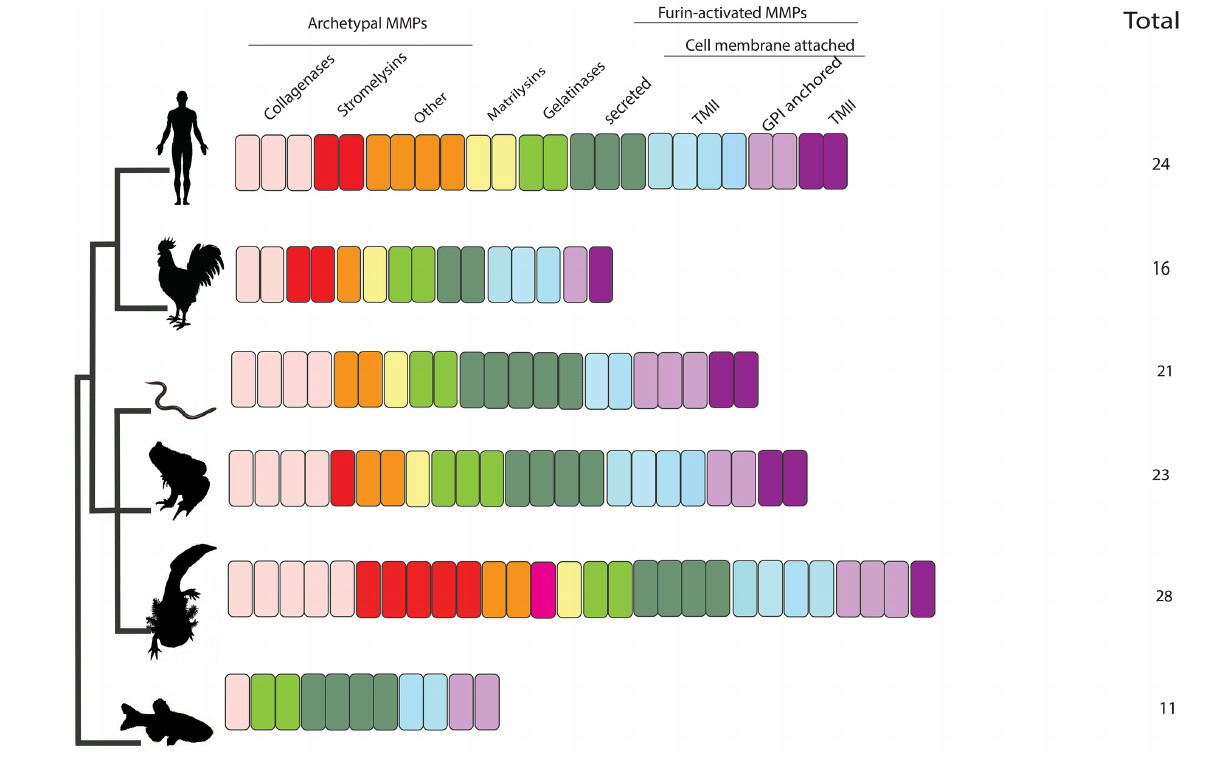
FIGURE 3 | Summary of number and classification of MMPs in axolotl and other tetrapods included in this study. Salamanders are predicted to encode the highest number of MMPs (28 gene members). Salamanders encode five collagenases:(Col-A, Col-B, Col-C, MMP13A, MMP13B), five stromelysins (MMP3/10A-E), others:(MMP19, MMP20), novel MMPe, matrilysin (MMP7), gelatinases (MMP2, MMP9), furin activated-secreted: (MMP11, MMP21, MMP21l, MMP28), -TMI: (MMP14, MMP15, MMP16, MMP24), -and GPI anchored: (MMP17, MMP17l, MMP25), and TMI: MMP23B. All of the salamander-specific presumptive novel MMPs are of the secreted